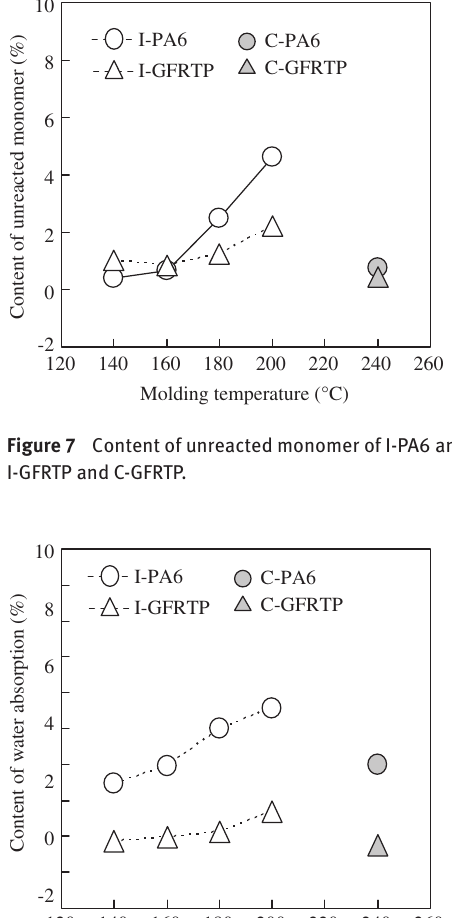
Figure 10 Water absorption of I-CFRTP and